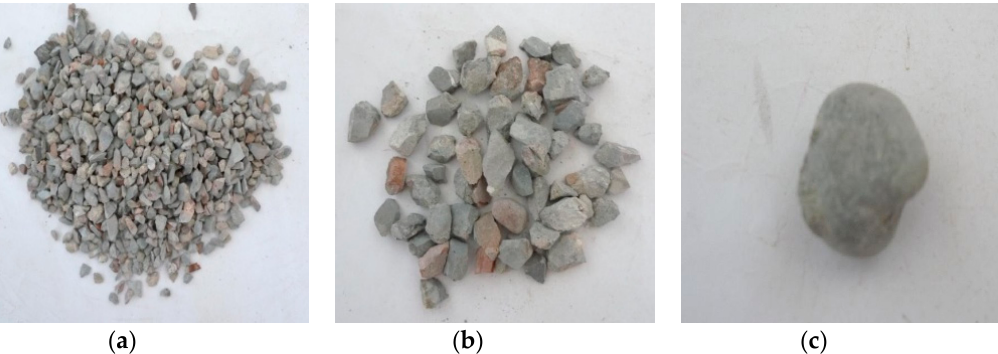
Figure 10 . Concrete particles after slow heating up to 600 °C and sieving (impact speed 18.36 m/s), water cooling. ( a ) 5 mm (62.78%); ( b ) 10 mm (23.08%); ( c ) 16 mm (14.08%).